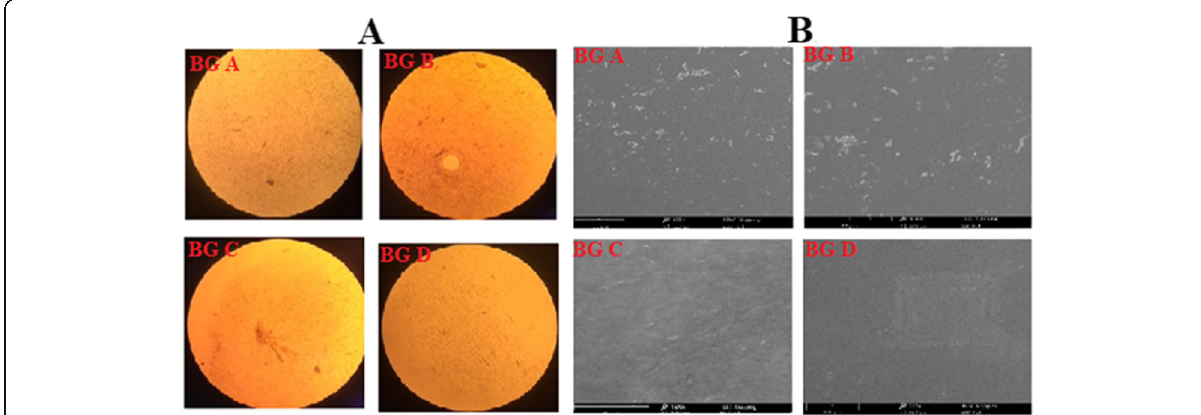
Fig. 1 a Light microscope images of the maraviroc/tenofovir bigel formulations BG A, BG B, BG C, and BG D. b SEM image of air-dried maraviroc/ tenofovir bigel formulations BG A, BG B, BG C, and BG